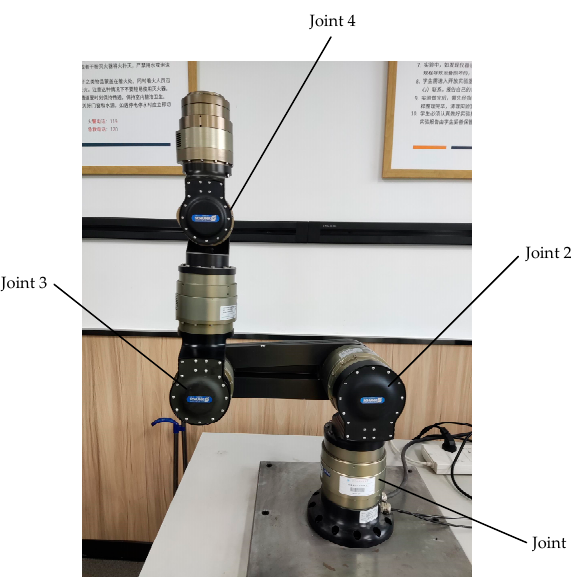
Figure 1. The structure of SCHUNK robot.